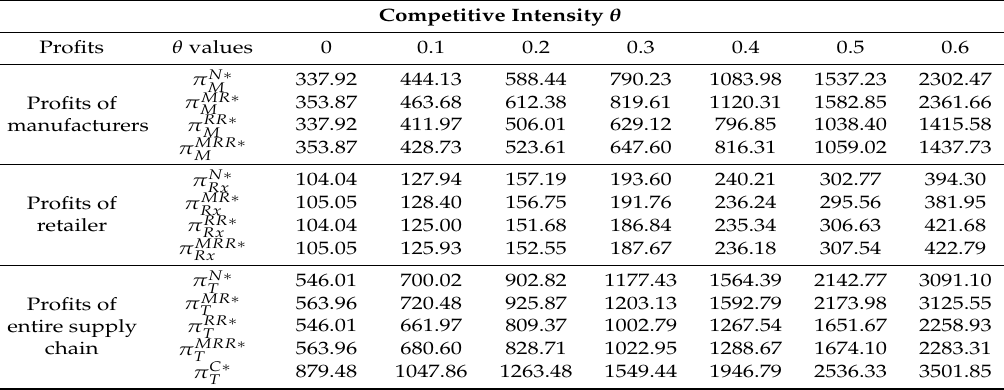
Table 5. The influence of competition intensity on the